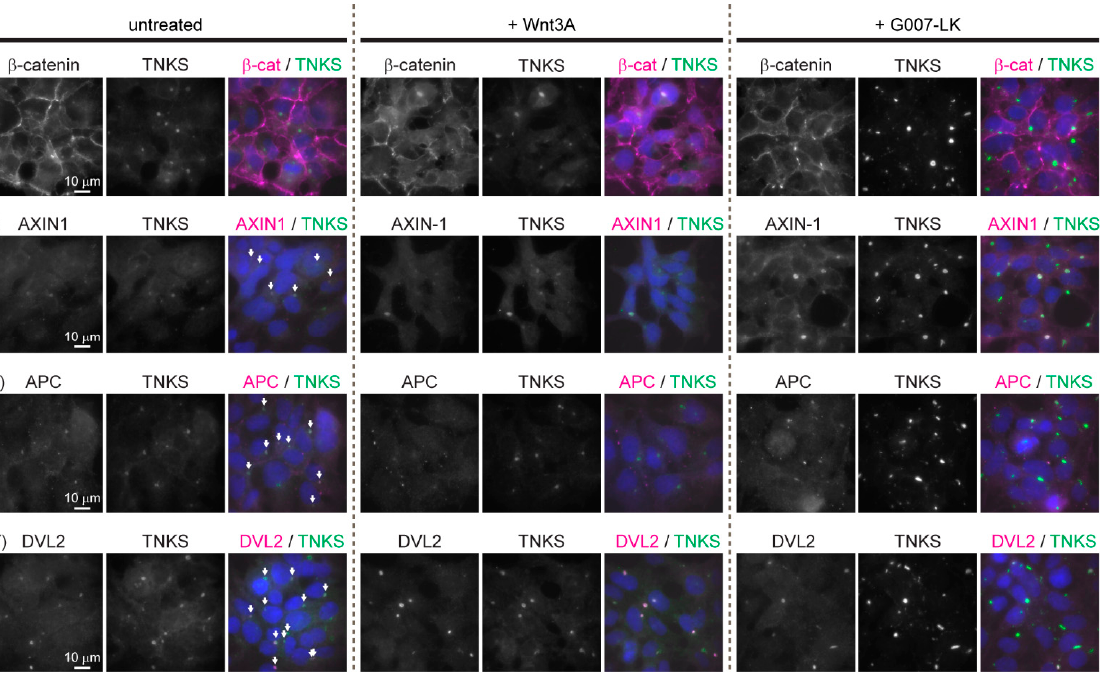
Figure 1. Key WNT/ β -catenin signaling components localizes in large cytoplasmic aggregates in HEK293 cells. Representative fluorescent images (wide field (WF)) of untreated, Wnt3A- and G007-LK-treated HEK293 cells immunostained for β -catenin, TNKS, AXIN1, APC and DVL2 as indicated. Single-channel and merged images are shown. Co-localization with TNKS is indicated with arrows in the merged image of untreated cells. In the merged images, nuclear counterstaining is shown in blue.